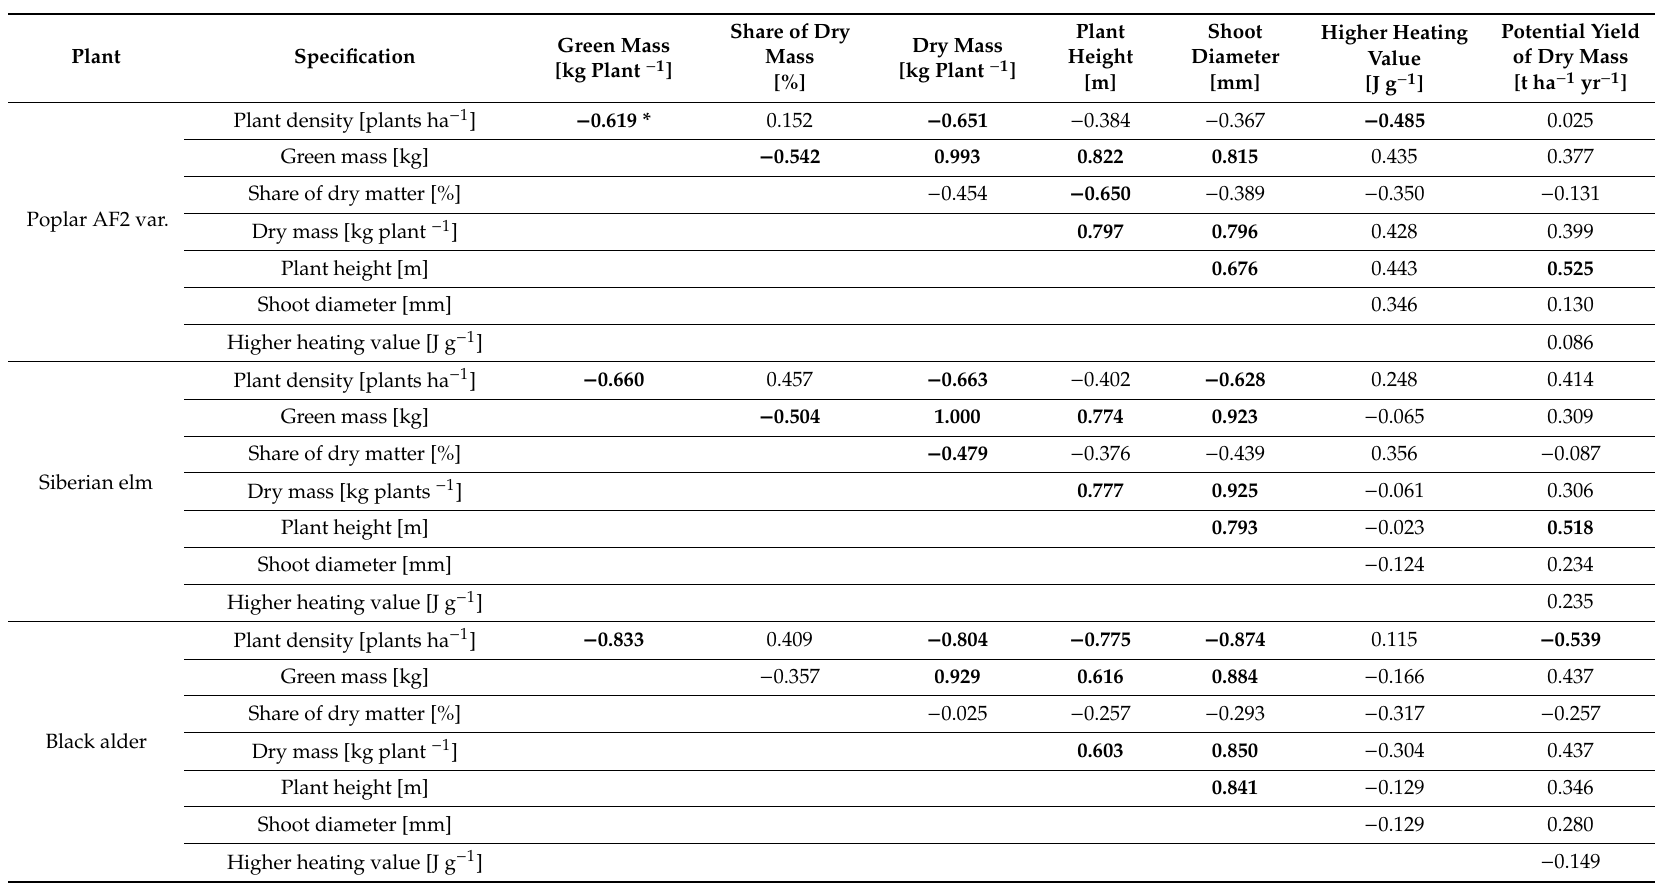
Table 3. Correlation matrix for the studied